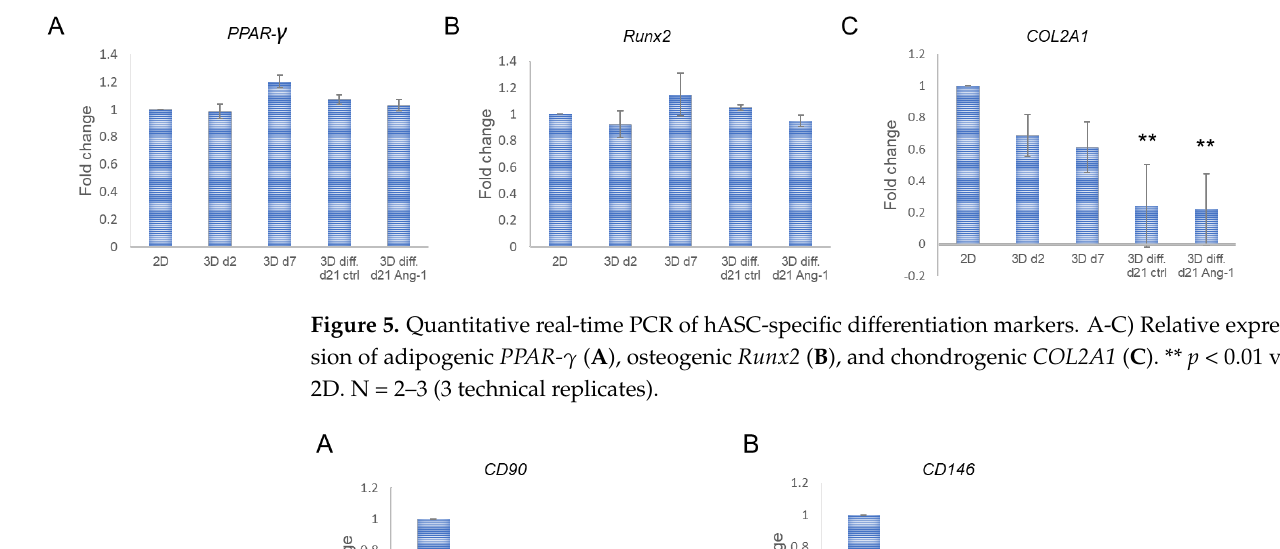
Figure 5. Quantitative real-time PCR of hASC-specific differentiation markers. A-C) Relative ex- pression of adipogenic PPAR- γ ( A ), osteogenic Runx2 ( B ), and chondrogenic COL2A1 ( C ). ** p < 0.01 vs. 2D. N = 2 – 3 (3 technical replicates).